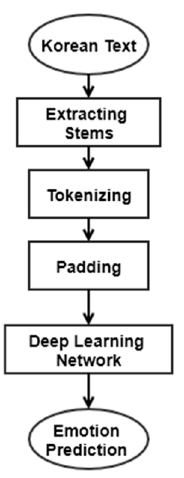
Figure 3. Structure of LUX sentiment analysis.